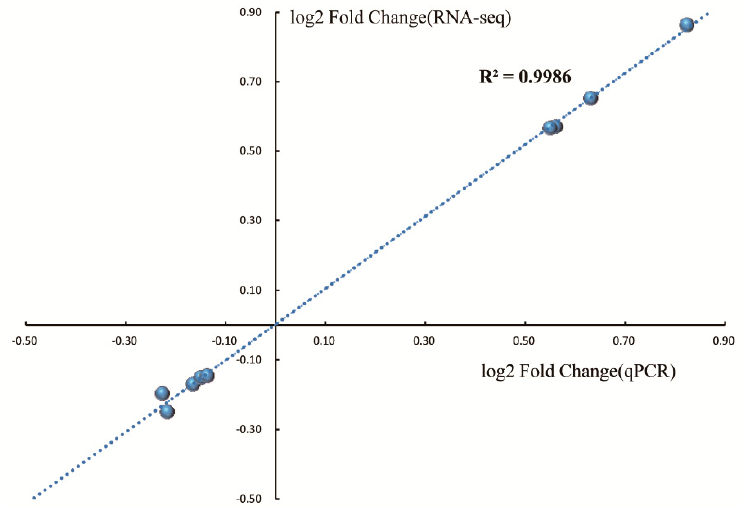
Figure 8. RT-qPCR validation of RNA-Seq experiments. The gene expression ratios obtained from both qPCR and RNA-Seq were normalized by a housekeeping control gene drm . Each group was performed with three biological replicates.